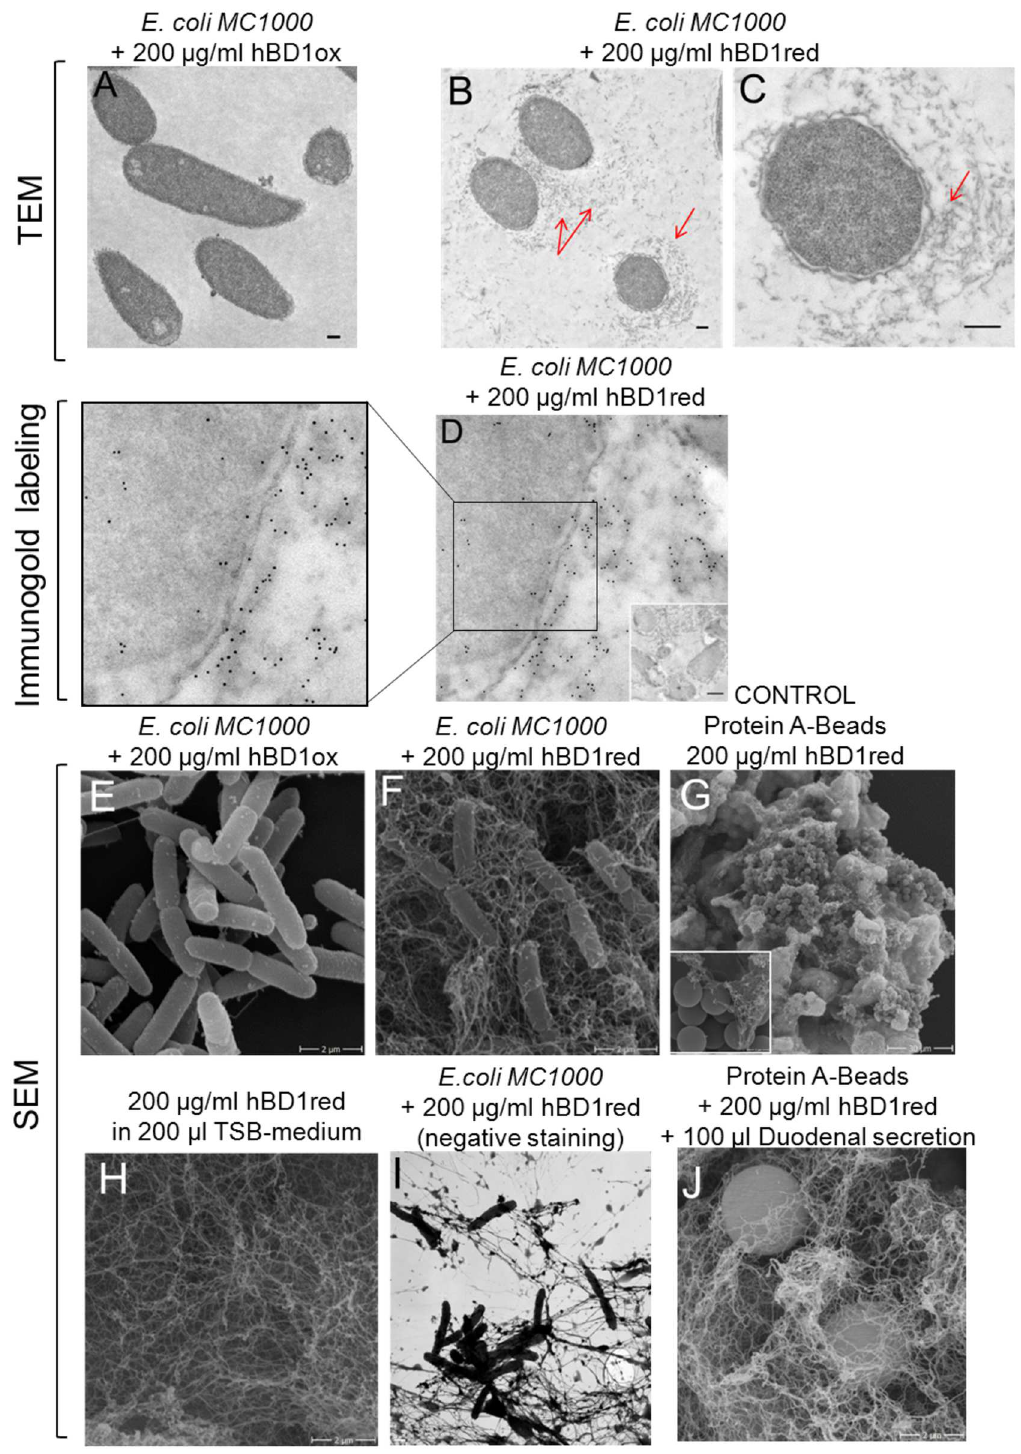
Fig 3. HBD1redforms netlike structures. Bacteria or beadswere treated with hBD1 redox forms for 2 h. Samples were fixed and visualizedby electronmicroscopy. (A-C) Transmissionelectronmicroscopyof E . coli MC1000for analyzingthe bacterialmorphology. HBD1red-treated E . coli cells displaystrong membrane defects and an unknown grey structure aroundthe bacteriawas detected. (D) E . coli MC1000was incubatedwith hBD1redand with antibodies againstthe peptide. The secondary antibodiesare conjugated to gold particles, 6 nm (black points). (E) E .